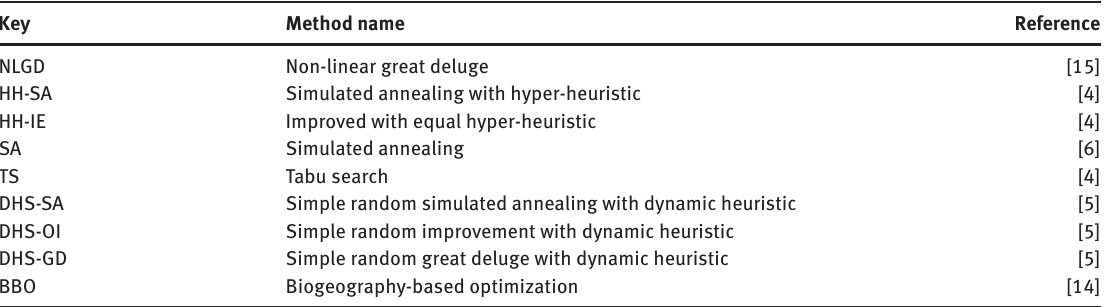
Table 7: Key to Comparative Methods for Solving the PAS Problem. Key